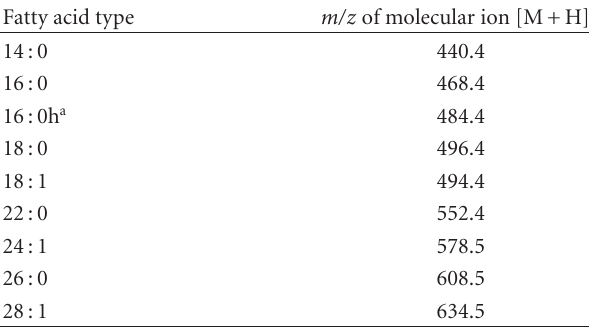
Table 1: N -acyl metabolites of 1 identified by ESI-MS in lipid extracts of di ff erentiated